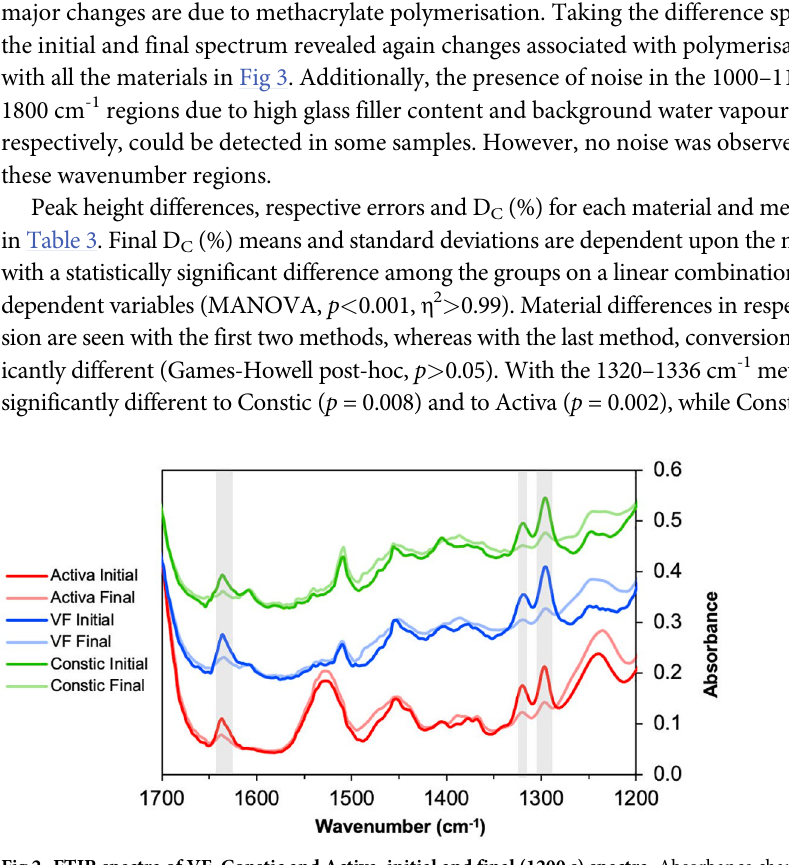
Fig 2. FTIR spectra of VF, Constic and Activa, initial and final (1200 s) spectra. Absorbance changes due to polymerisation can be seen at the C-O stretch doublet at 1300 and 1320 cm -1 together with 1636 [v(C = C)] bond, highlighted in grey. Samples with 2 mm thickness, light cured for 20 s ( n =